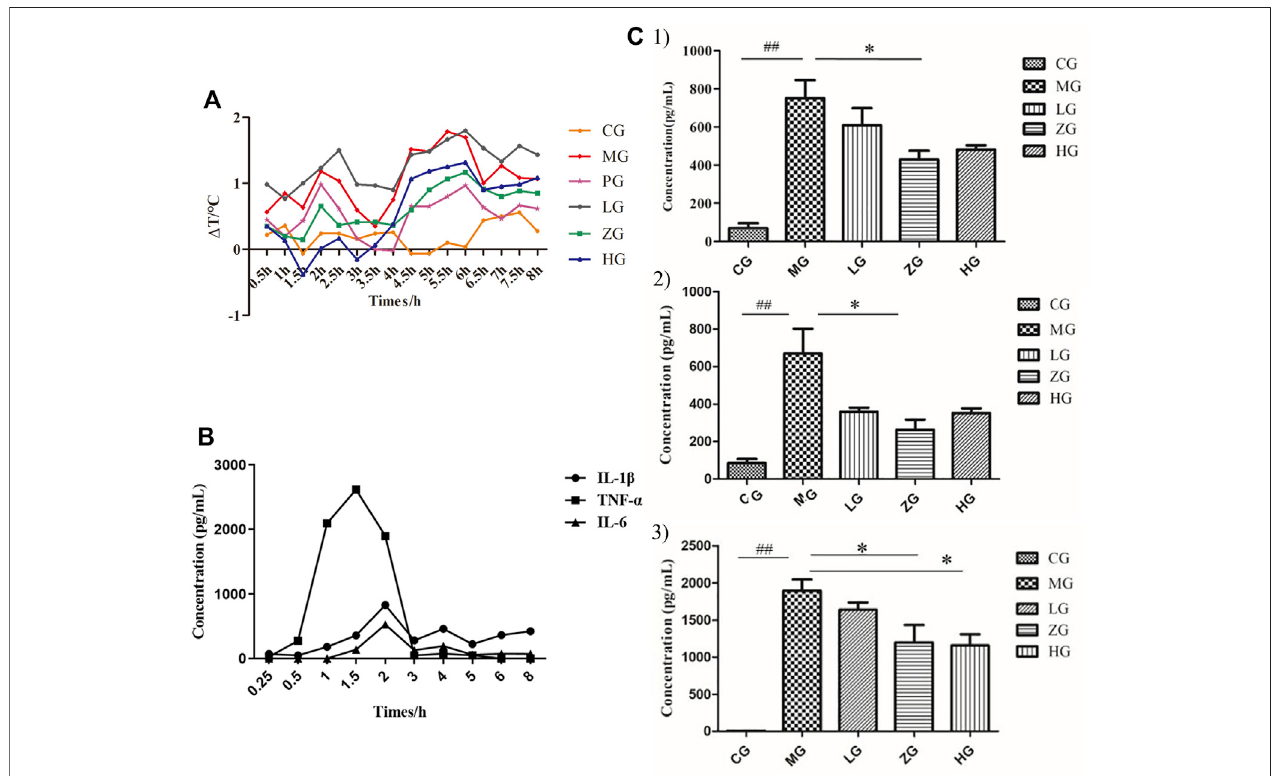
FIGURE 1 | Regulation of physiological and biochemical indicators levels induced by LPS and its reduction by SHL treatment. (A) The trends of temperature differencetotime ( Δ T)ofratsineachgroup( n =8); (B) Changesinthelevelofpro-in fl ammatory cytokines(IL-1 β ,IL-6,andTNF- α )ofserum samplescollectedatdifferent time points in model groups; (C) The levels of pro-in fl ammatory cytokines of serum samples at 2 h-point blood sampling. (1: IL-1 β ; 2: IL-6; and 3: TNF- α ). Data were expressed as mean ± SD (* p < 0.05 model groups compared with the SHL treatment groups, ## p < 0.01 compared with the control groups, CG, normal control group, MG, model group, LG, SHL low-dose group, ZG, SHL medium-dose group; HG, SHL high-dose